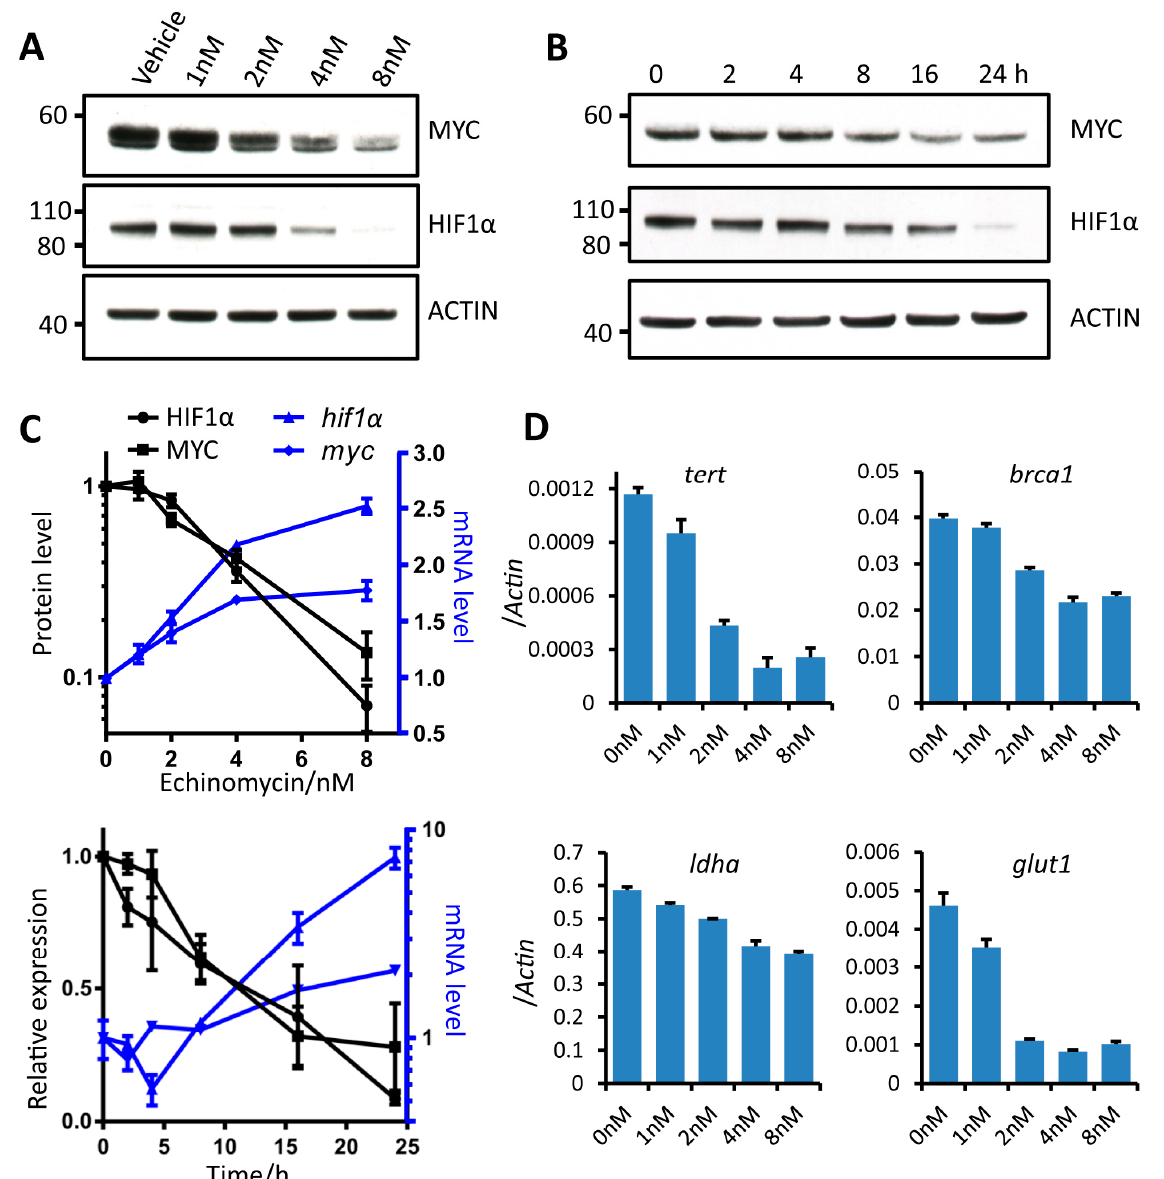
Figure 1. Echinomycin reduced MYC and HIF1 α proteins but increased their mRNAs. ( A ) Western blot analysis of MYC and HIF1 α proteins in H1944 lung adenocarcinoma cells treated with echinomycin at indicated concentrations for 24 h. Experiments were repeated 4 times. The uncropped Western blots have been shown in Figure S14. ( B ) Time-dependent decrease of MYC and HIF1 α proteins in H1944 cells treated with 4nM echinomycin at indicated time points. Experiments were repeated 3 times. ( C ) Quantification of MYC and HIF1 α protein levels ( n = 4 replicates) and myc and hif1 α RNAs in H1944 lung adenocarcinoma cells treated for 24 h with echinomycin at indicated concentrations (upper panel) ( n = 3 replicates) or treated with 4nM echinomycin at indicated time points (lower panel) ( n = 2 replicates). Experiments were repeated 3 times. ( D ) Expression of MYC and HIF1 α target genes in H1944 cells treated with echinomycin at indicated concentrations for 24 h by qRT-PCR ( n = 3 replicates). Experiments were repeated 2